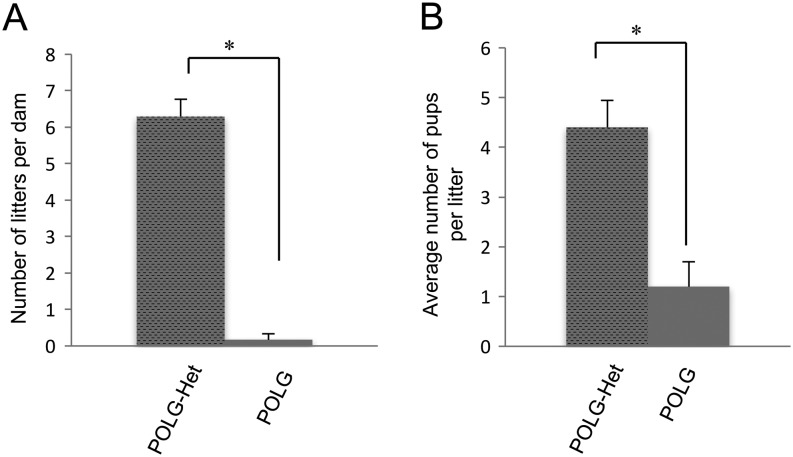
Female POLG mitochondrial DNA mutator mice have reduced fertility as compared to heterozygous littermates. The number of litters per dam (A), and number of pups per litter (B), is shown for mice heterozygous (Polg
D257A/+; POLG-het) and homozygous (Polg
D257A/D257A; POLG) for the POLG mutation over a 12-month period, with male-pairing beginning at 6 weeks of age (n = 10 female mice per group, *P < 0.001).